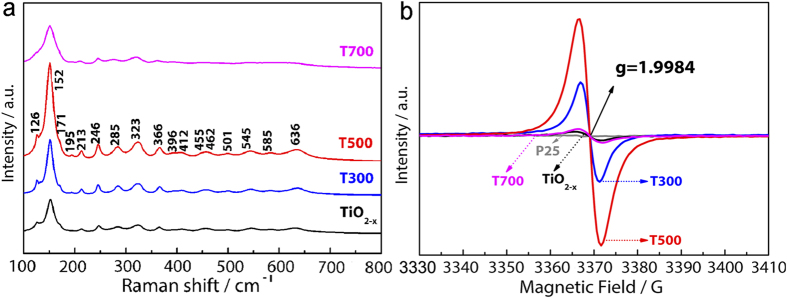
(a) Raman spectra and (b) low-temperature EPR spectra of the brookite TiO2−x, T300, T500 and T700 samples.